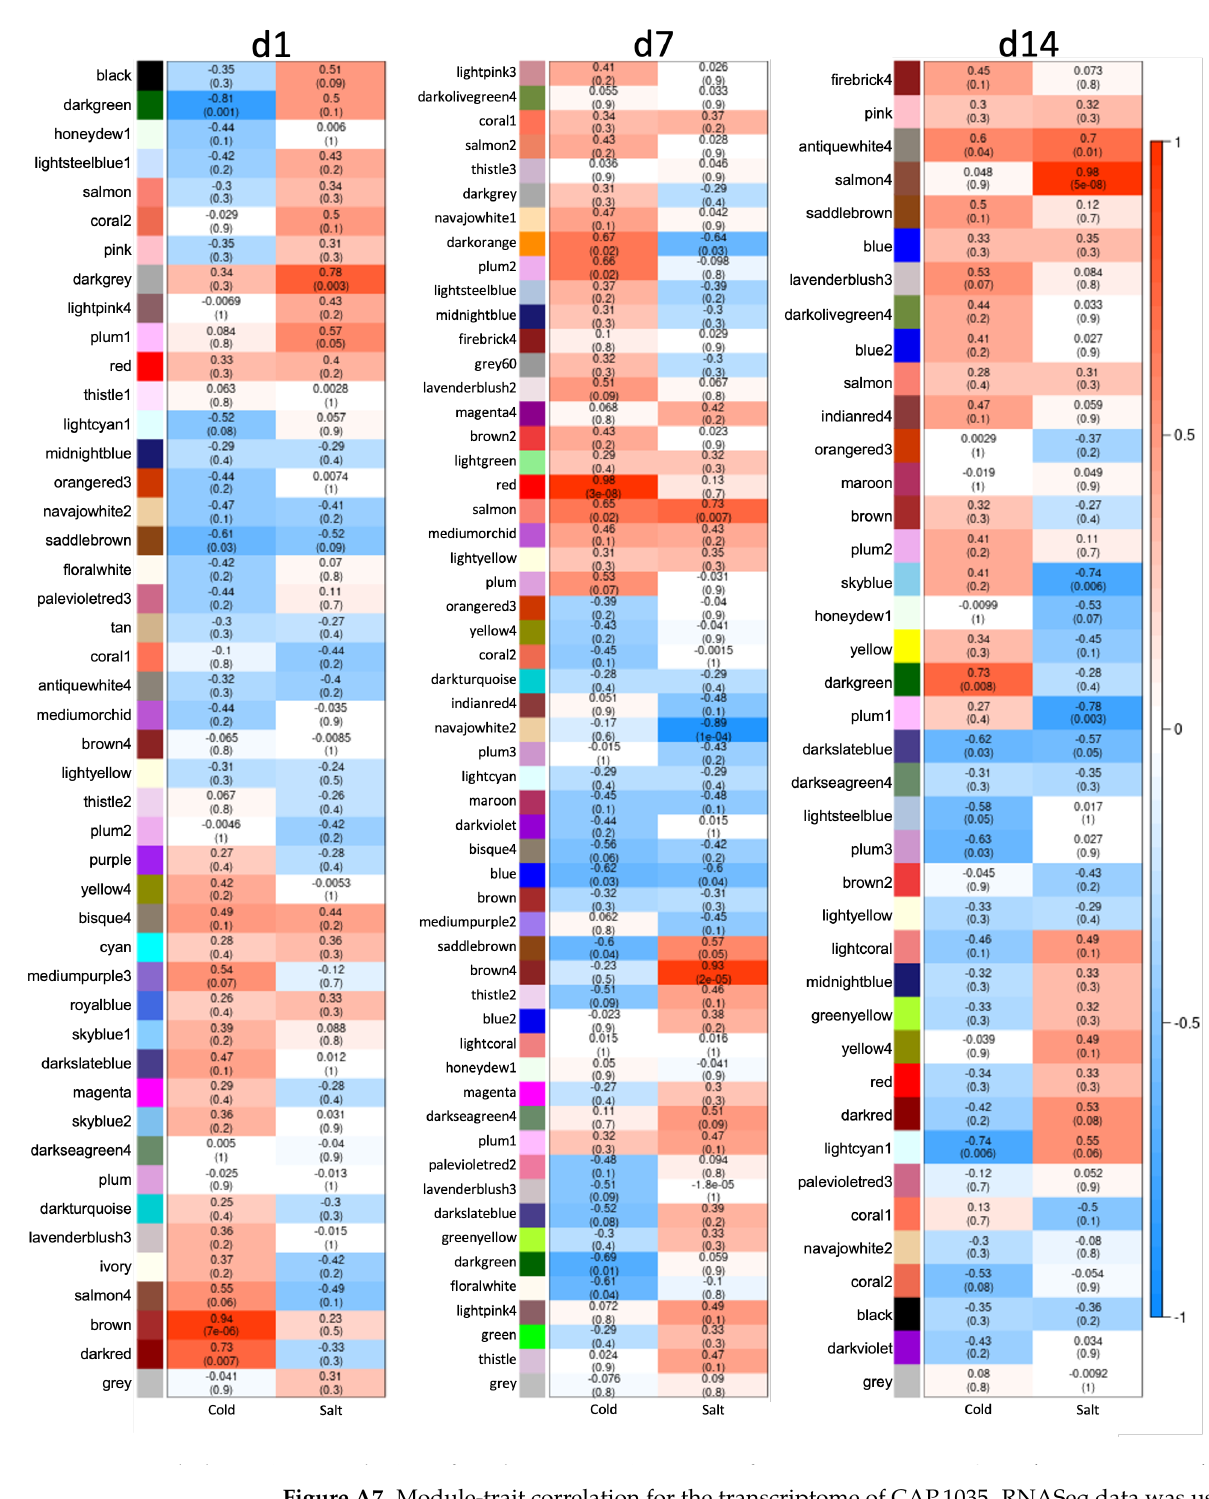
Figure A7. Module-trait correlation for the transcriptome of CAP 1035. RNASeq data was used to perform a weighted cluster analysis. Shown here is the relationship for each identified cluster with the single stress chilling temperature (cold), or salt as indicated at d1, d7 or d14. On the y-axis, all identified modules are listed with their respective names. Color and number indicate the correlation between module and binary trait for eigengenes and numbers in brackets the p -Value for significance.